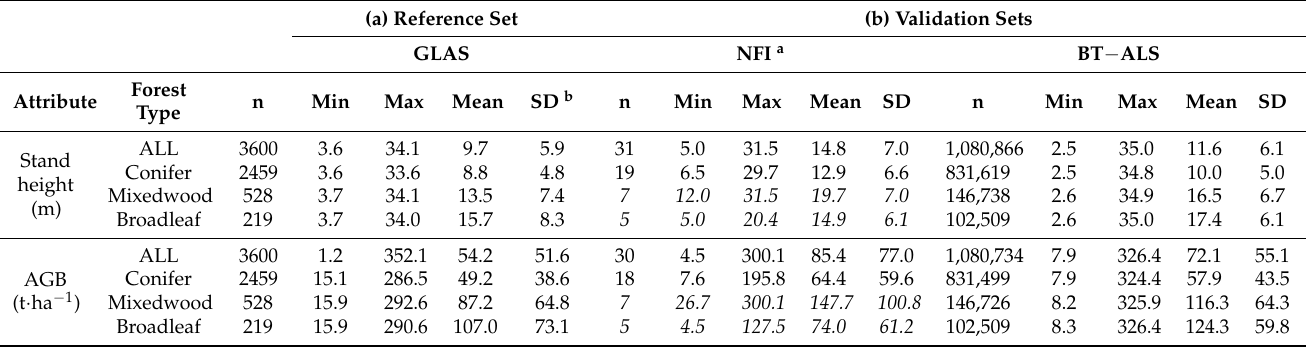
Table 3. Descriptive statistics for ‘’observed” stand height and aboveground biomass (AGB) using all samples that are also partitioned by three forest cover types for (a) reference set from GLAS surrogate and (b) two validation sets: National Forest Inventory (NFI) plots and BT − ALS LiDAR plots. Descriptive statistics for all five attributes are reported in Table